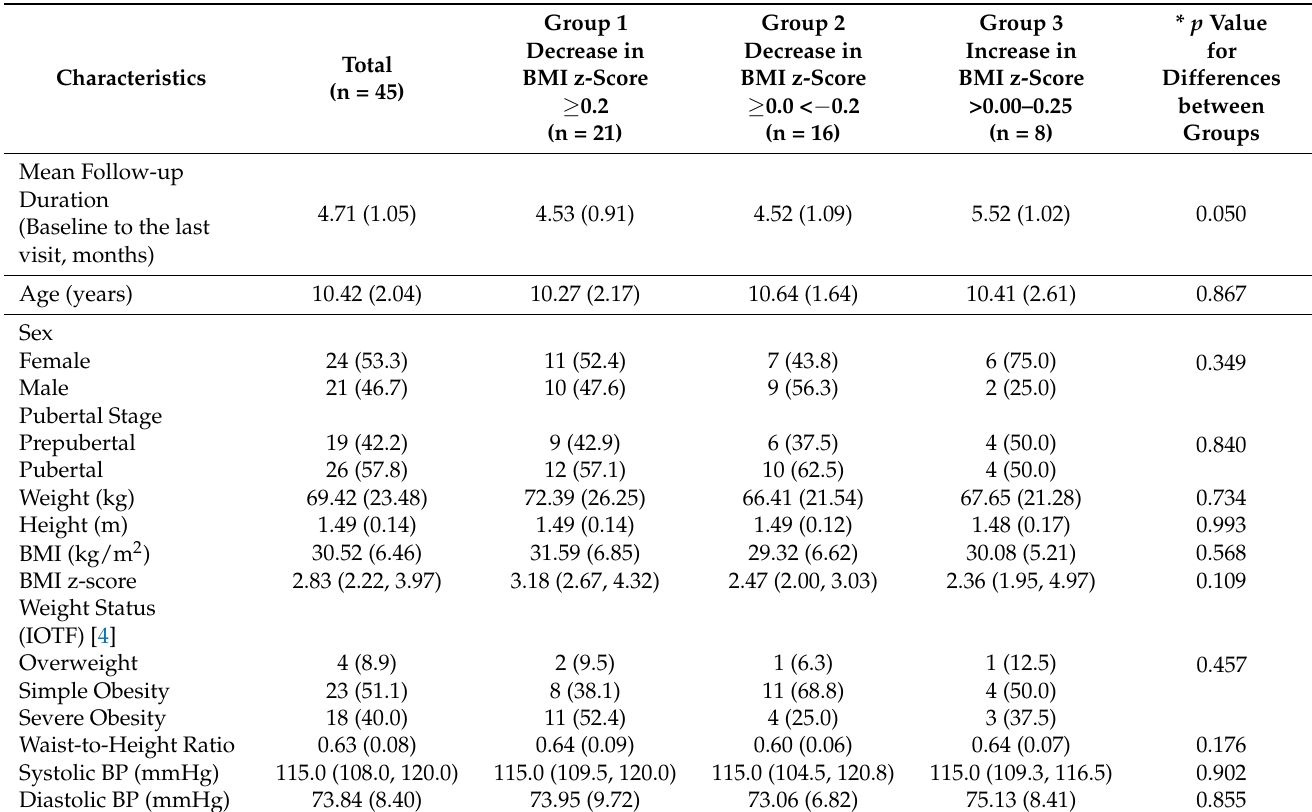
Table 1. Characteristics of children according to BMI z-score